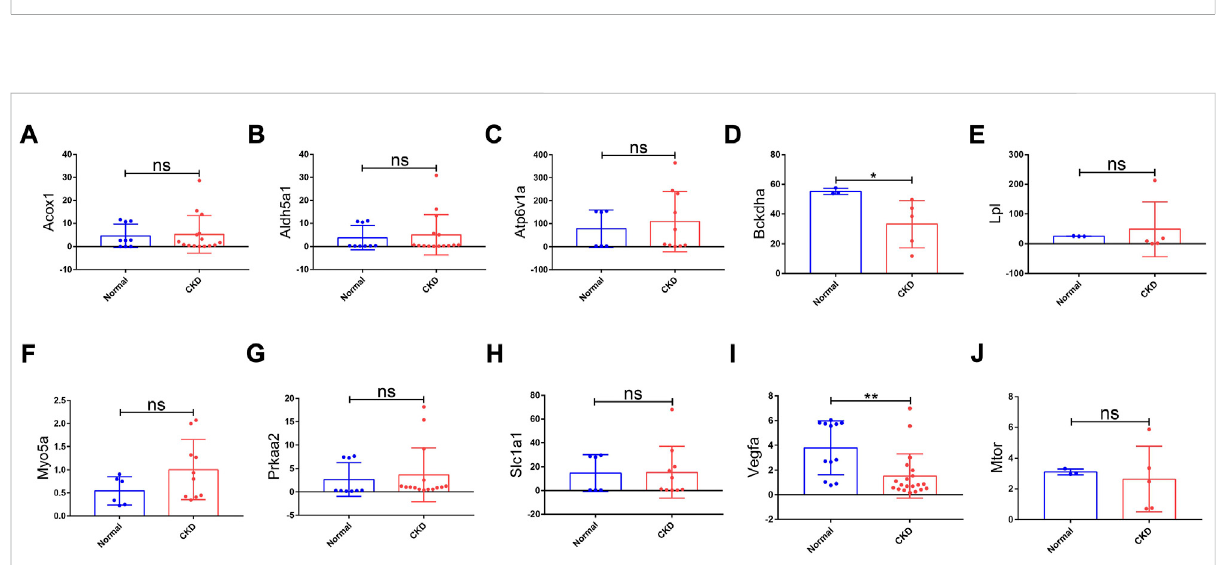
FIGURE 7 KEGG pathway analysis of DEmiRNAs, GO enrichment analysis of hub genes, and hub gene – KEGG interaction network. (A) KEGG pathway analysisof4DEmiRNAsobtainedfrommiRPathV3.0. (B) Top20GOtermsofhubgenes.ThecirclesrepresentGOterms. (C) Top10termsofBP,CC, and MF of hub genes. (D) Hub gene – KEGG interaction network. No pathways matched “ Pi4ka, ” “ Myo5a, ” and “ Aldh5a1 ” hub genes. Purple octagons indicate hub genes, while green circles indicate pathways. KEGG, Kyoto Encyclopedia of Genes and Genomes; DEmiRNAs, differentially expressed miRNAs; GO, Gene Ontology; BP, biological process; CC, cellular component; MF, molecular function.